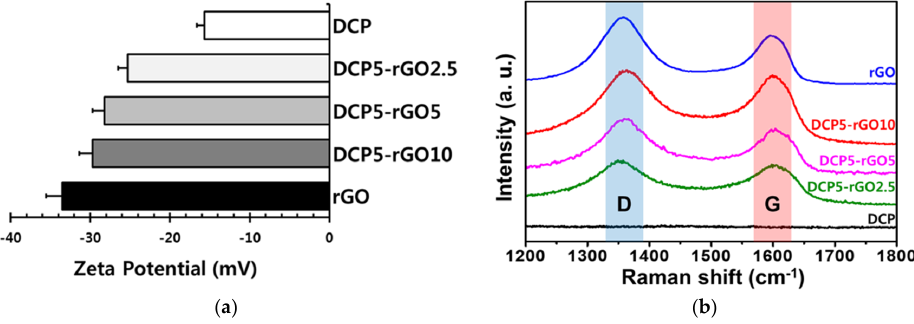
Figure 3. Characterizations of DCP microparticles and DCP ‐ rGO hybrid composites. ( a ) Surface charges and ( b ) Raman spectra of DCP microparticles and DCP ‐ rGO hybrid